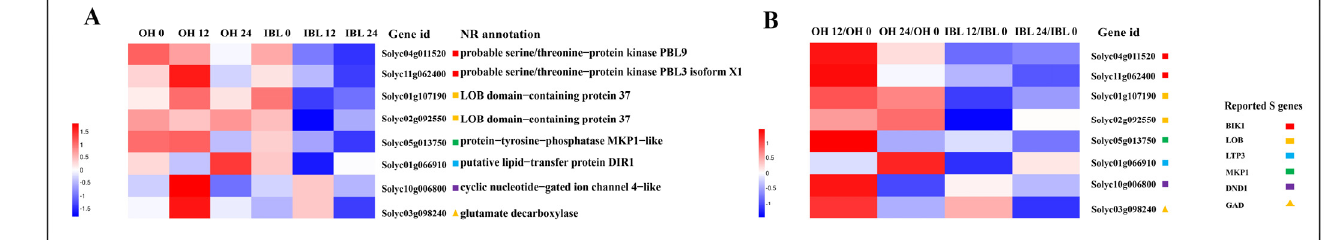
Figure 6. Heat map profiles of S gene homologs. ( A ) The quantitative analysis of gene expression at three time-points in two lines. OH 0, OH 12, and OH 24 represent the normalized expression values at 0 hpi, 12 hpi, and 24 hpi in Ohio88119; IBL 0, IBL 12, and IBL 24 represent the normalized expression values at 0 hpi, 12 hpi, and 24 hpi in IBL2353. ( B ) The contrasts of gene expression pattern in two lines. Data were the Log2 value of gene expression fold changes and were normalized based on Z-score formula. The blue color means the value was lower than the mean of the same row of four values from two lines at different time-points, and not the down-regulation. The red color represented the value was higher than the mean of the same row of four values from two lines at different time-points, but not up-regulation. The darker color represents the higher deviation from the average. OH 12/OH 0 and OH 24/OH 0 represent the ratio of gene expression value at 12 hpi and 24 hpi compared to at 0 hpi in Ohio88119, respectively; IBL 12/IBL 0 and IBL 24/IBL 0 represent the ratio of gene expression value at 12 hpi and 24 hpi compared to value at 0 hpi in IBL2353, respectively.